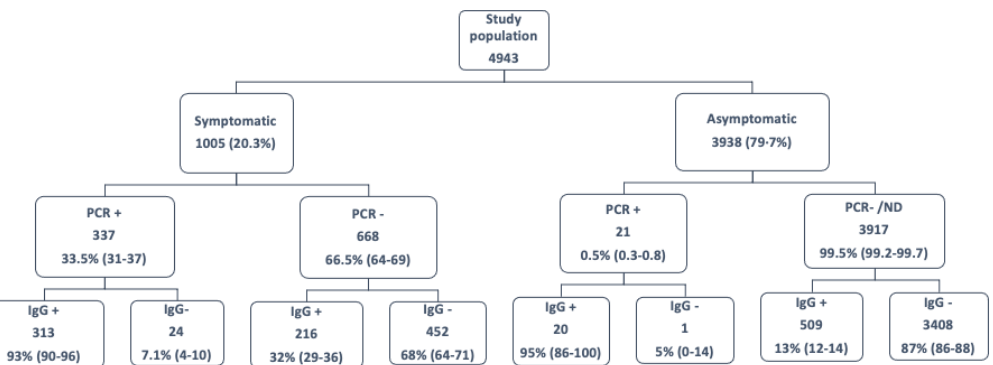
Figure 1. Flow diagram of 4943 HCWs included in the study after participation in the seroprevalence survey, classified according to the presence of symptoms, PCR result, and specific serology result (IgG+/IgG − ). Between parentheses, 95% confidence interval of each rate.